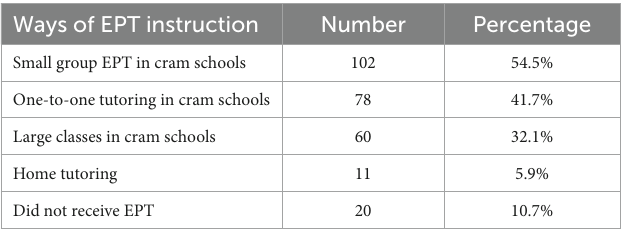
TABLE 3 The ways of EPT instruction students